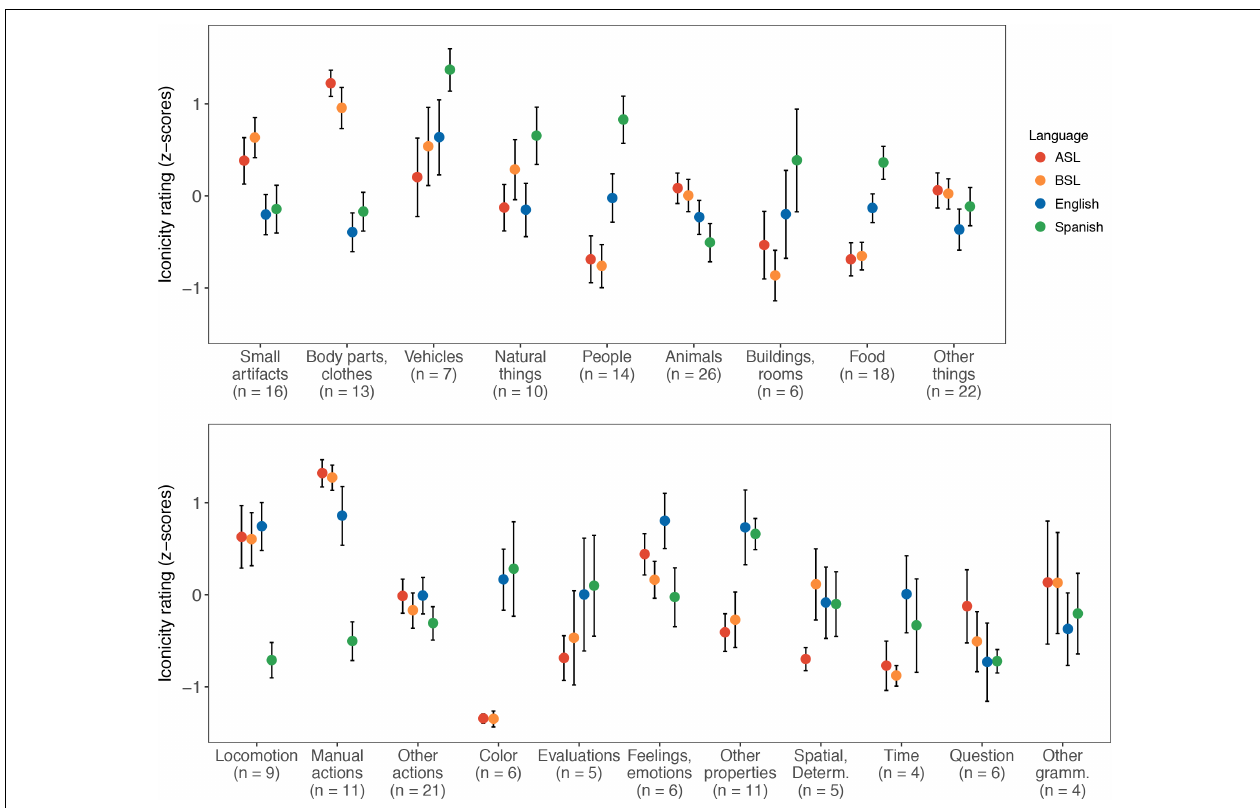
FIGURE 3 | Means and standard errors of normalized iconicity ratings by specific semantic category. (Top) Shows categories of nouns. (Bottom) Shows categories spanning adjectives, verbs, and other lexical classes.